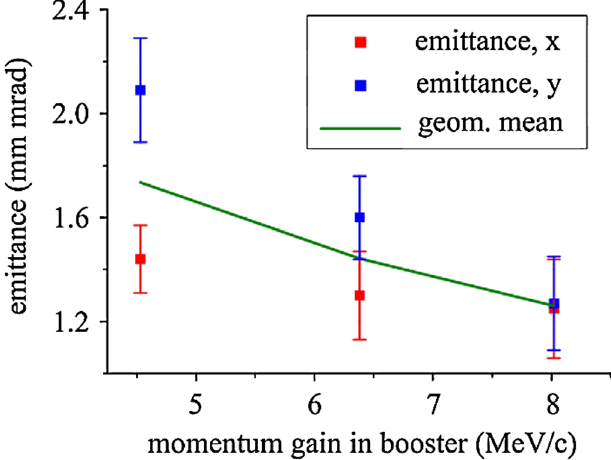
momentum gain in the